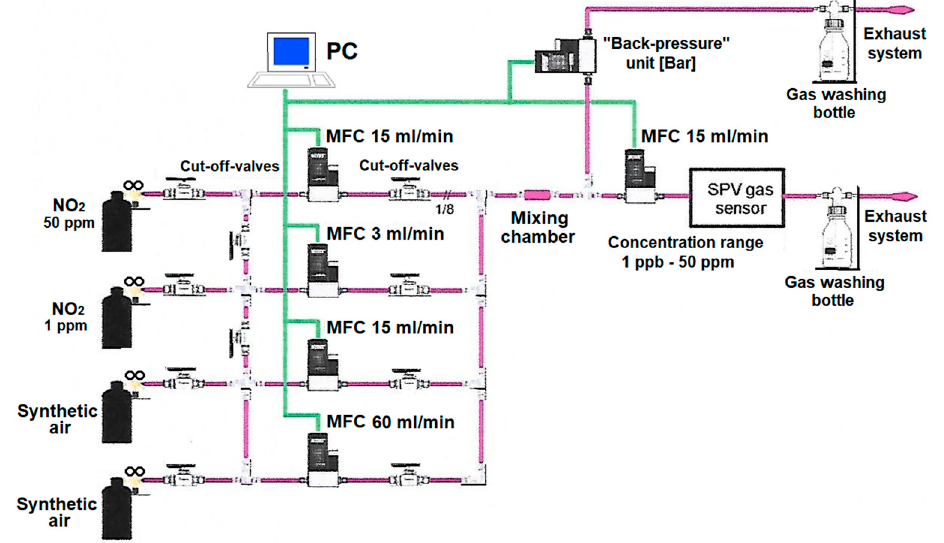
Figure 1. Simplified block-scheme of NO 2 gas dilution, mixing and dosing system for use with the surface photovoltage (SPV) gas sensor system (the device).